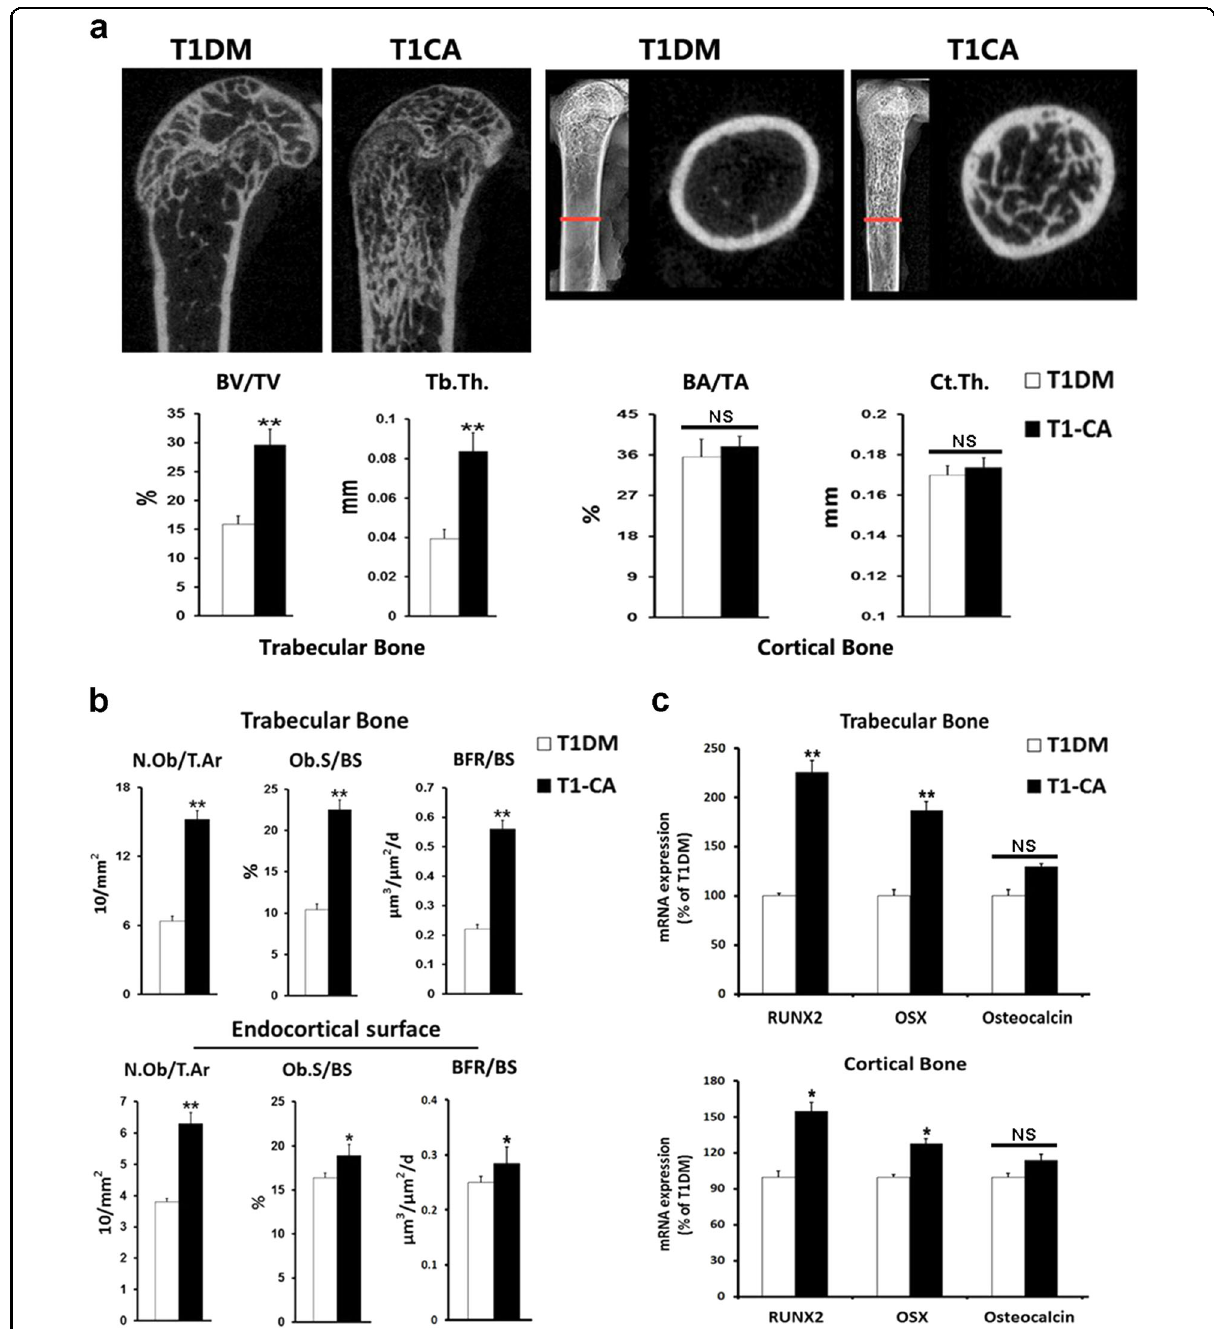
Fig. 3 Osteoblastic activation of β -catenin in T1DM mice led to greater extent of bone mass increment and increase of osteogenic activities in trabecular bone compared with cortical bone. a Representative Micro-CT longitudinal reconstructed images of distal femur and cross-sectional images of the femoral diaphysis. BV/TV, Tb.Th (Trabecular bone), BA/TA, and Ct.Th (Cortical bone) are shown. n = 9/control, 7/T1DM. b Static and dynamic histomorphometric analyses in the trabecular bone and endocortical surface of the femur. n = 9. c mRNA expression levels of osteoblast markers in trabecular and cortical bone. n = 8. Data are expressed as the mean ± SD. * P < 0.05, ** P < 0.01 versus T1DM group by an unpaired t -test. NS not signi fi cant, P >